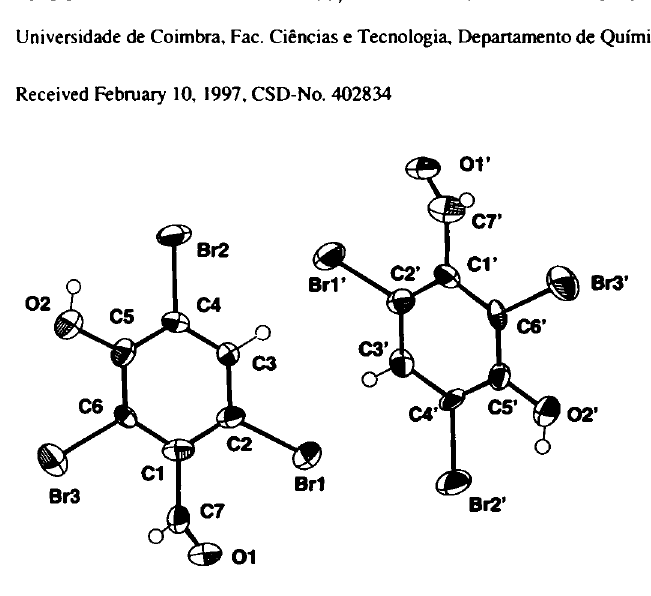
The molecules fomi infinite one-dimensional chains parallel to the